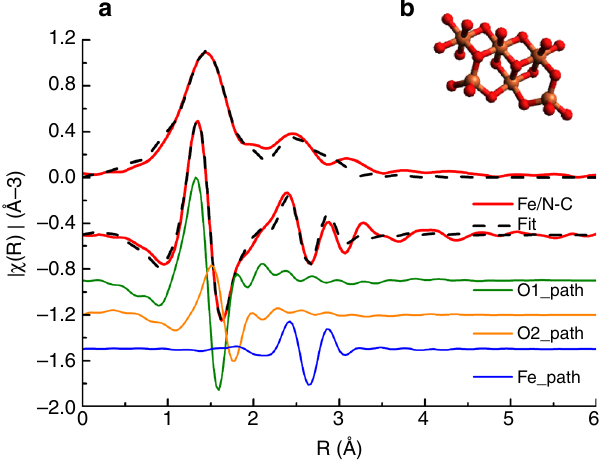
Fig. 2 Non-phase-corrected k 2 weighted Fourier transform EXAFS data of Fe/N-C sample. a Non-phase-corrected k 2 weighted Fourier transform EXAFS data of Fe/N-C as an example. The imaginary part of the data, fi t (using scattering paths calculated from cif fi le PDF 00-058-0898.cif of ferrihydrite) and scattering paths are also shown to visualize the in fl uence of each path to the spectrum; b model of the Fh -FeOOH structure from PDF 00-058-0898.cif .Color code: Fe = orange, O = red